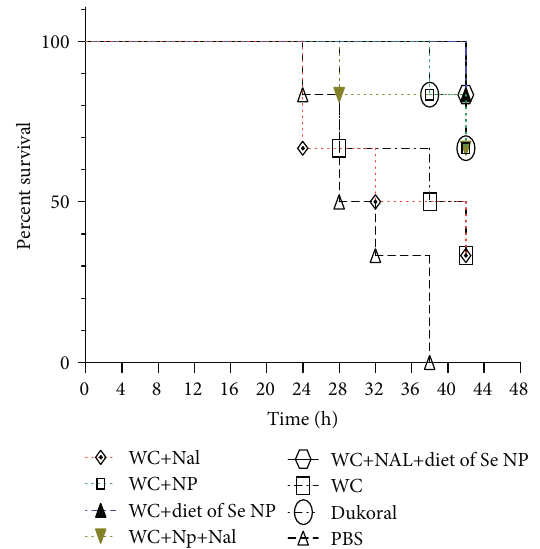
Figure 9: Percent survival of neonatal mice in challenge with whole- cell V. cholerae . Survival curves in neonate challenge were analyzed by the log-rank test ( P < 0 : 001